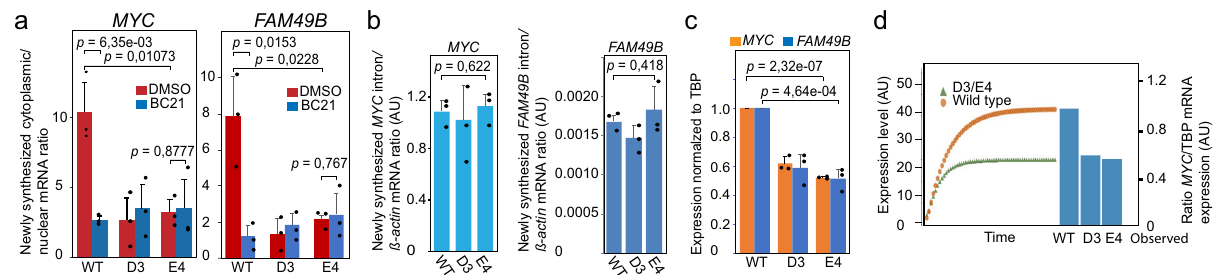
Fig. 2 The CCAT1 -speci fi c CTCFBS increases MYC and FAM49B expression by facilitating the nuclear export of MYC and FAM49B mRNAs in a WNT- dependent manner. a The rate of nuclear export of newly synthesized MYC and FAM49B mRNAs in WT and mutant HCT-116 cells in the absence or presence of BC21 (see Methods). b The transcriptional rate of the MYC and FAM49B genes. The data were generated by qRT-PCR analyses of MYC/ FAM49B transcription using newly synthesized (30 min ethynyl-uridine pulse) RNA as template and normalized to ACTB transcription. c The steady state levels of cytoplasmic MYC and FAM49B mRNAs in WT and mutant HCT-116 cells normalized to TBP expression and external “ spike in ” RNA controls. The levels of TBP and ß-actin mRNA expression, markers used to normalize the mRNA export and transcription rates, were not signi fi cantly different between the WT and D3/E4 cells and correctly estimated the number of input cells (Supplementary Fig. 2a, b). d Comparison between observed and simulated cytoplasmic MYC RNA levels in WT HCT-116 and E4 cells. The simulation used the parameters of nuclear export of MYC mRNA ( a ), transcriptional rate ( b ), and the kinetics of MYC mRNA decay in the nuclear and cytoplasmic compartments, as described before 7 . The data represent in all instances